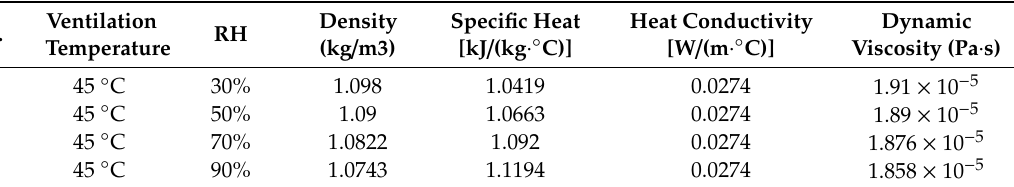
Table 5. Settings of the spray cooling simulations.